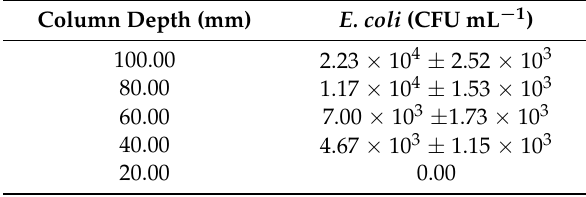
Table 1. Number of cells extracted from each 20 mm segment cut at different depths; 100 mm is the top of the column ( n = 3).